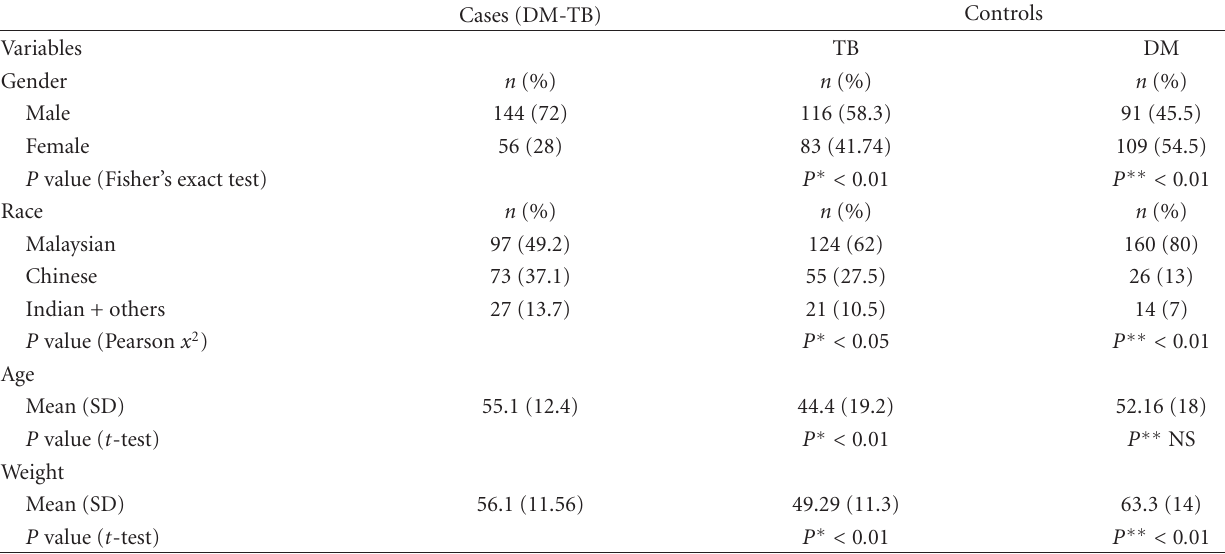
Table 2: Demographic characteristics of study